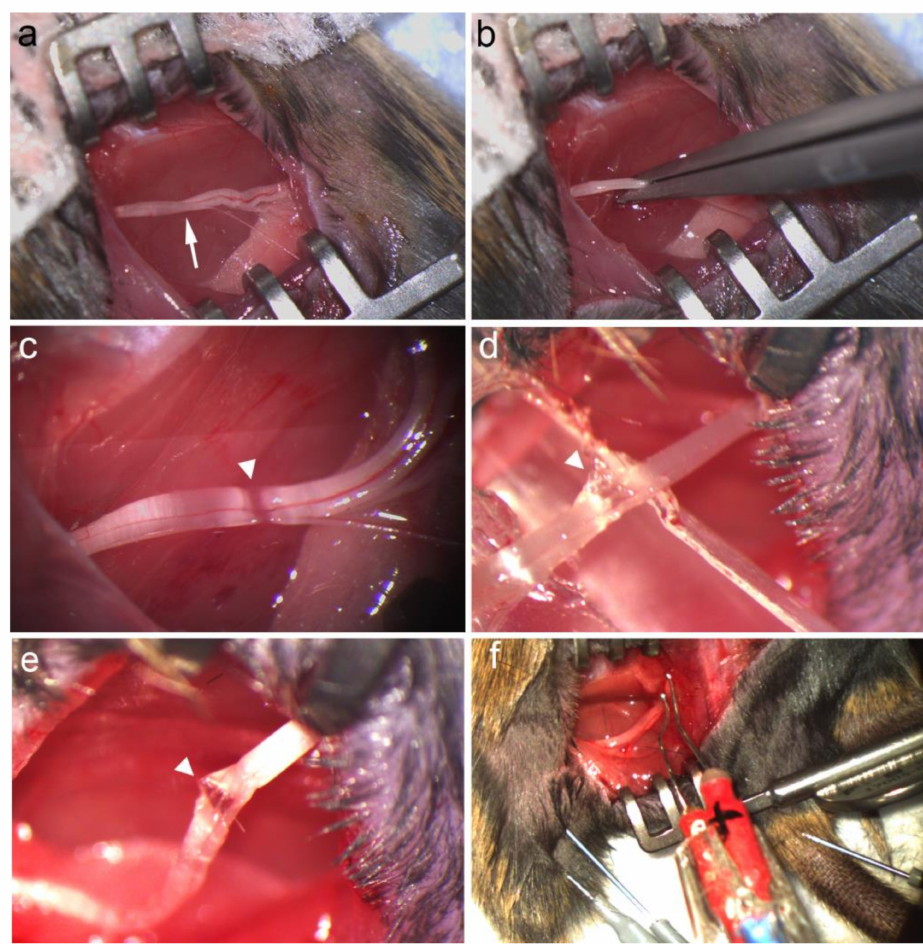
Figure 1. Representative surgical exposure for crush injury method and CMAP recording. ( a ) Exposure of the sciatic nerve (white arrow shows measured crush site 10 mm proximal to the sciatic nerve trifurcation point). ( b ) Crushing the sciatic nerve using #5 jewelers’ forceps applying constant force in a vertical direction for 30 s, followed by horizontal compression for an additional 30 s. ( c ) Verification of crush injury site with preserved nerve continuity (white arrowhead). ( d ) Custom spacer designed to implement 30 g of stretch to the nerve at the predetermined notch while crush is simultaneously performed (white arrowhead stretch–crush site). ( e ) Stretch–crush injury site (white arrowhead) after custom spacer removal; note that nerve continuity is preserved. ( f ) Bipolar direct stimulation and recording electrodes in gastrocnemius muscle setup for NCV and CMAP recording. CMAP, compound muscle action potential; NCV, nerve conduction